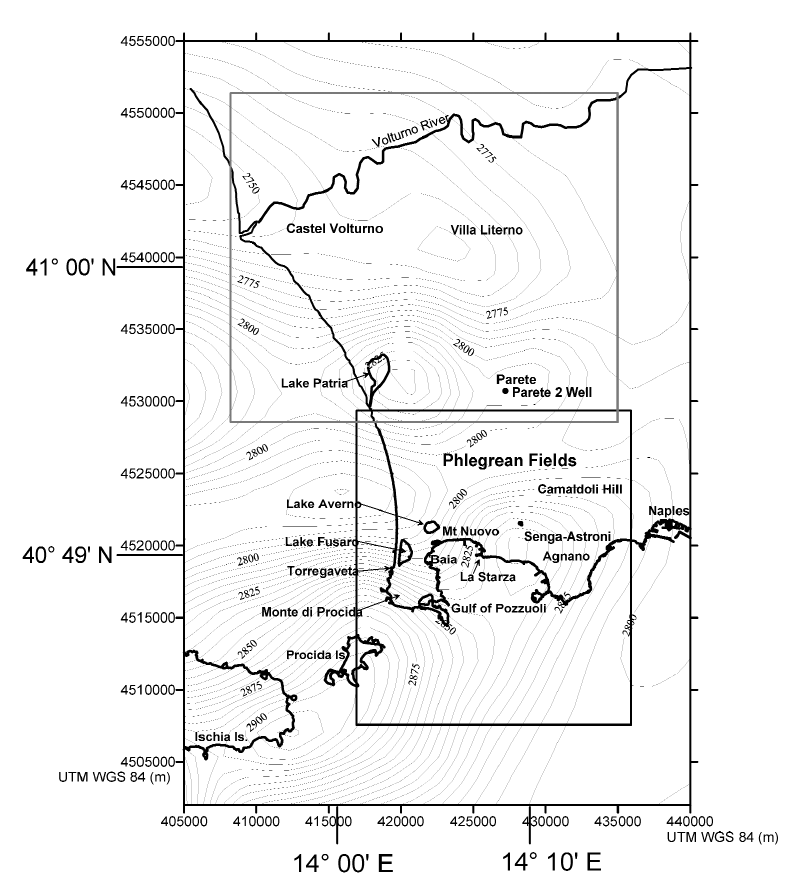
Fig. 1. The regional aeromagnetic map of the Phlegrean area measured by Agip (1981). The black rectangle shows the area surveyed by Agip in 1985 at a high resolution, while the grey rectangle shows the area surveyed in the new surveys of 1999 and